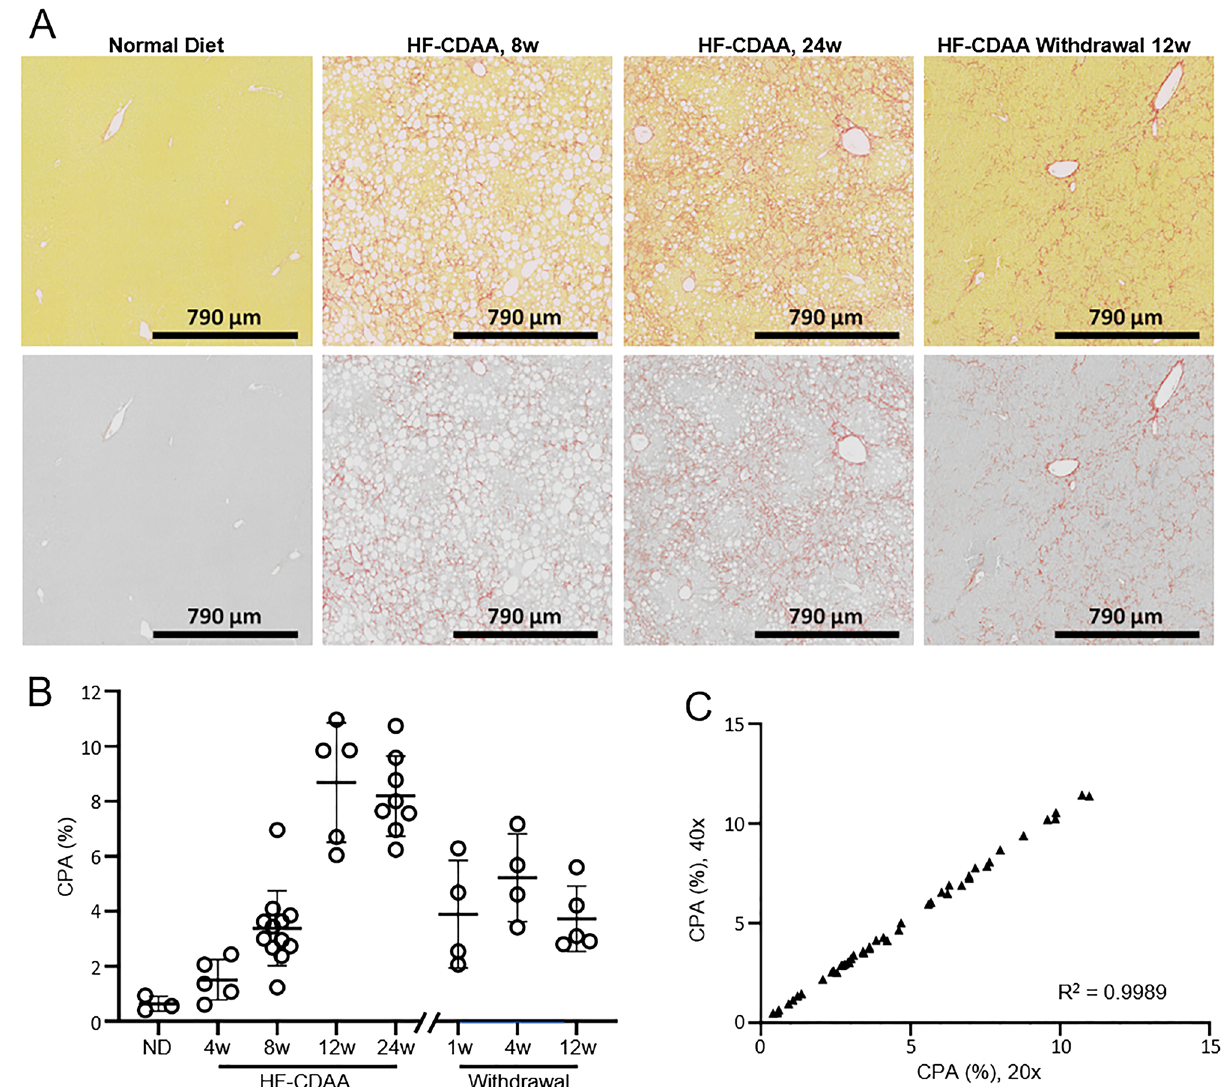
Figure 2. ( A ) Representative images of liver sections from HF-CDAA-treated mice at weeks 0 (normal diet), 8 (8w), 24 (24w) and a recovery period of 12 weeks following 8 weeks HF-CDAA treatment; the upper panel corresponds to native images of picrosirius red-stained liver sections, the bottom panel shows the corresponding digital images, obtained with MorphoQuant software, in which collagen fibers were pseudocolored in red and liver tissue in grey. ( B ) Evolution of collagen proportionate area (CPA%) after HF-CDAA treatment relative to selected time points and after HF-CDAA withdrawal following an 8-week HF-CDAA induction. ( C ) Correlation of CPA values obtained in the same picrosirius red-stained sections at 20 × and 40 × respectively using MorphoQuant software. Results were expressed as mean value ± SD (n = 3 sections/mouse, 6–10 mice/group). R 2 : coefficient of determination. p value < 0.05 was considered statistically